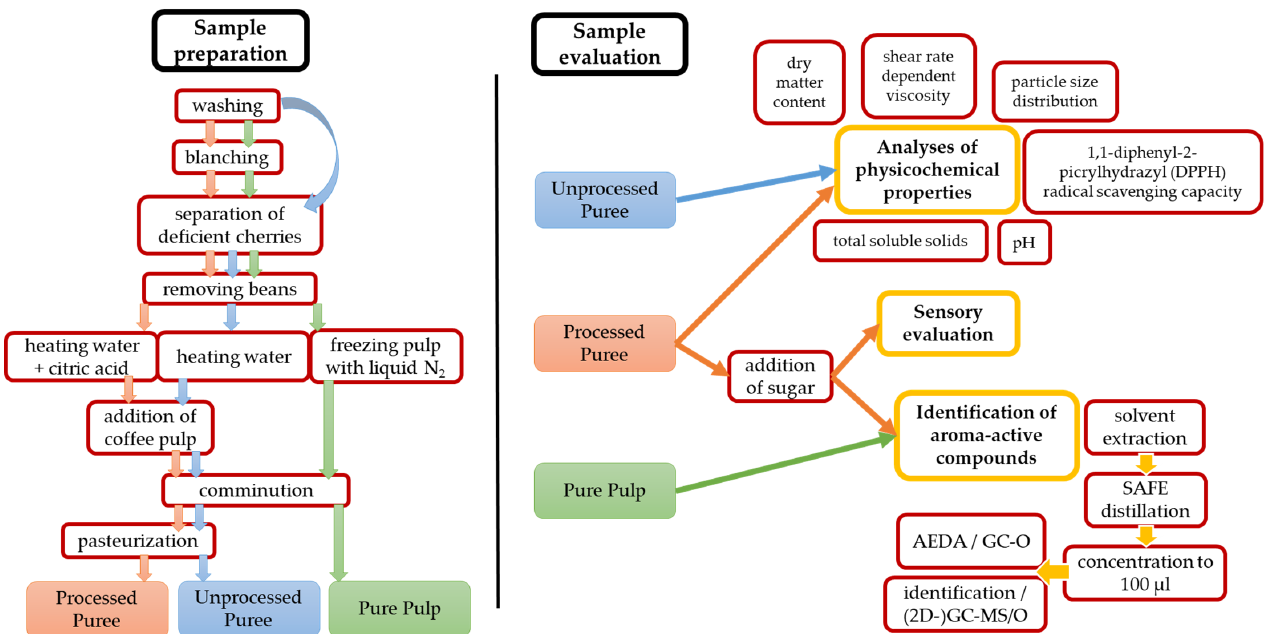
Figure 4. Schematic overview of the methodology used for this study.